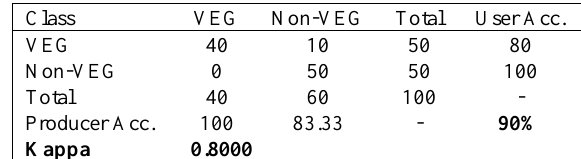
Table 8. Error Matrix for the classified scene (160/43) of 1992 Class VEG Table 9. Error Matrix for the classified scene (160/43) of 1986